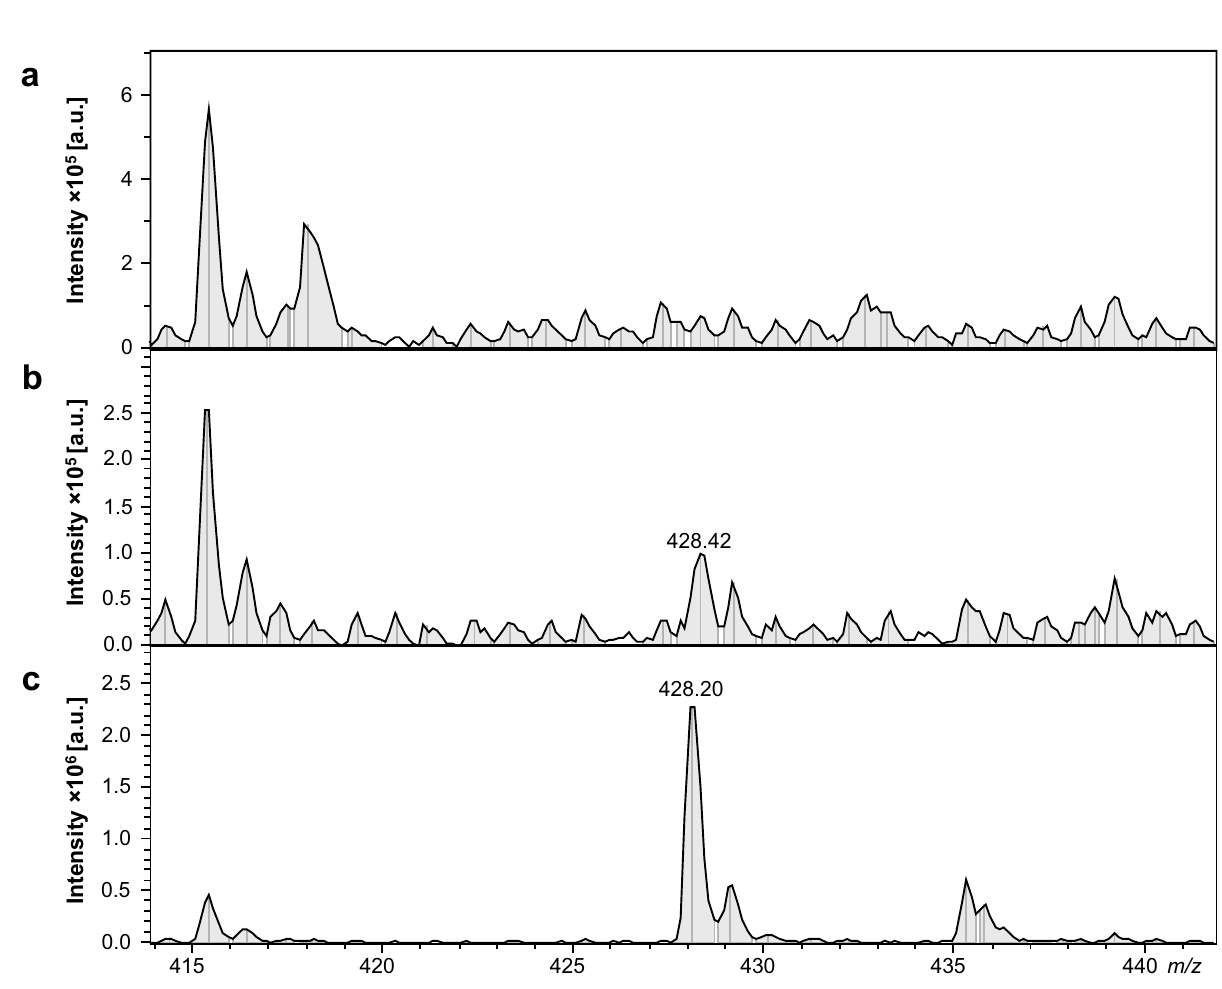
Figure 2. Mass spectra of the frontal cortex: control ( a ), 25I-NBOMe 0.3 mg/kg ( b ), 25I-NBOMe 0.3 mg/kg × 7 ( c ), indicating the occurrence of the 25I-NBOMe precursor ion (~ 428 m/z); a.u. arbitrary